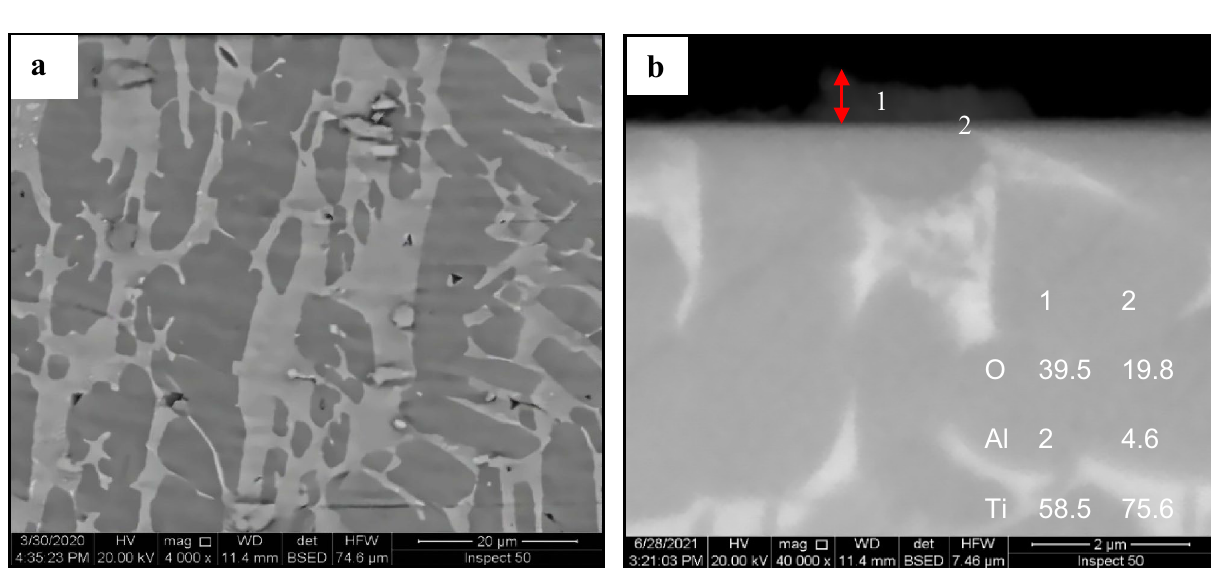
Figure 5. SEM and EDS analysis for oxide specimens at 600 °C after 50 h exposure ( a ) morphology, and (b)